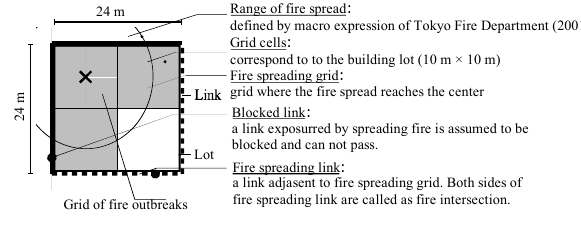
Figure 2. Road damage by spread of fire